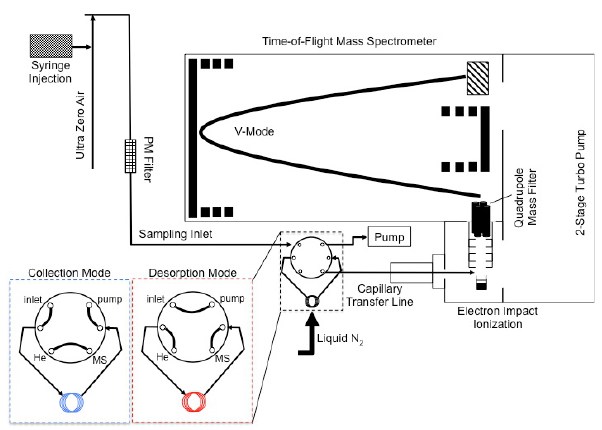
Fig. 1. Schematic of the I/SVOC instrument and inlet as configured during the AAFEX-II campaign. The inset shows the 6-way valve orientation for collection (blue) and desorption (red) modes of op- eration. See text for